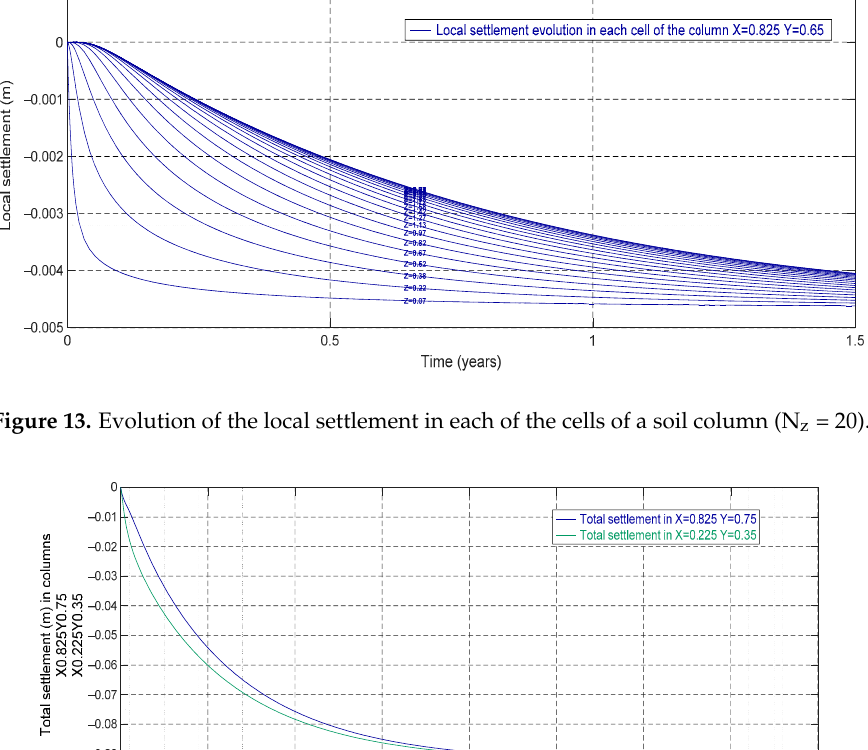
Figure 14. Surface settlement evolution of two soil columns.